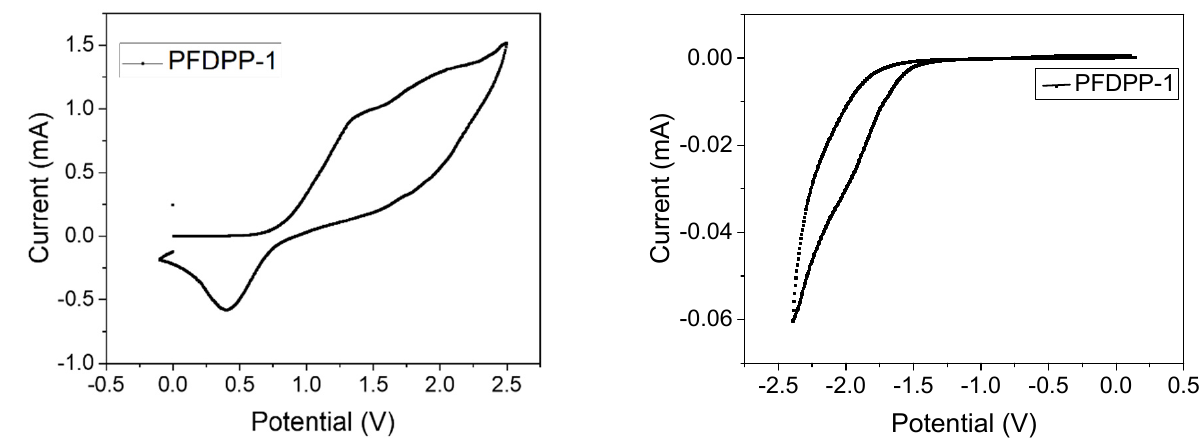
Figure 8. Cyclic voltammograms of PFDPP-1 film polymer (oxidation left and reduction right ).